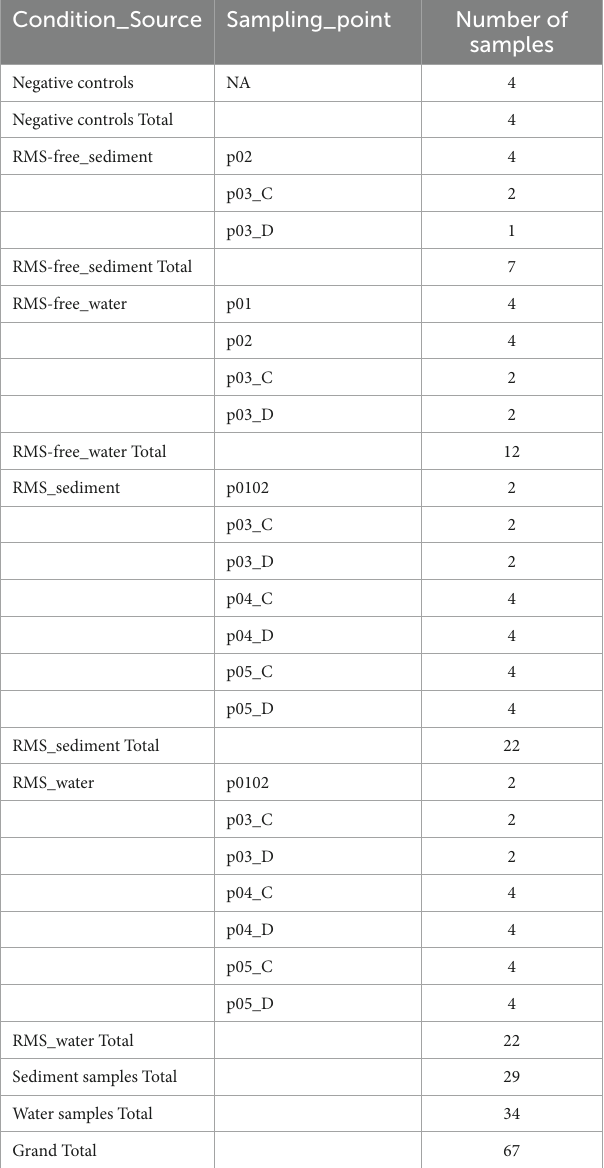
TABLE 1 Samples list, grouped by “Condition_Souce” and detailed for